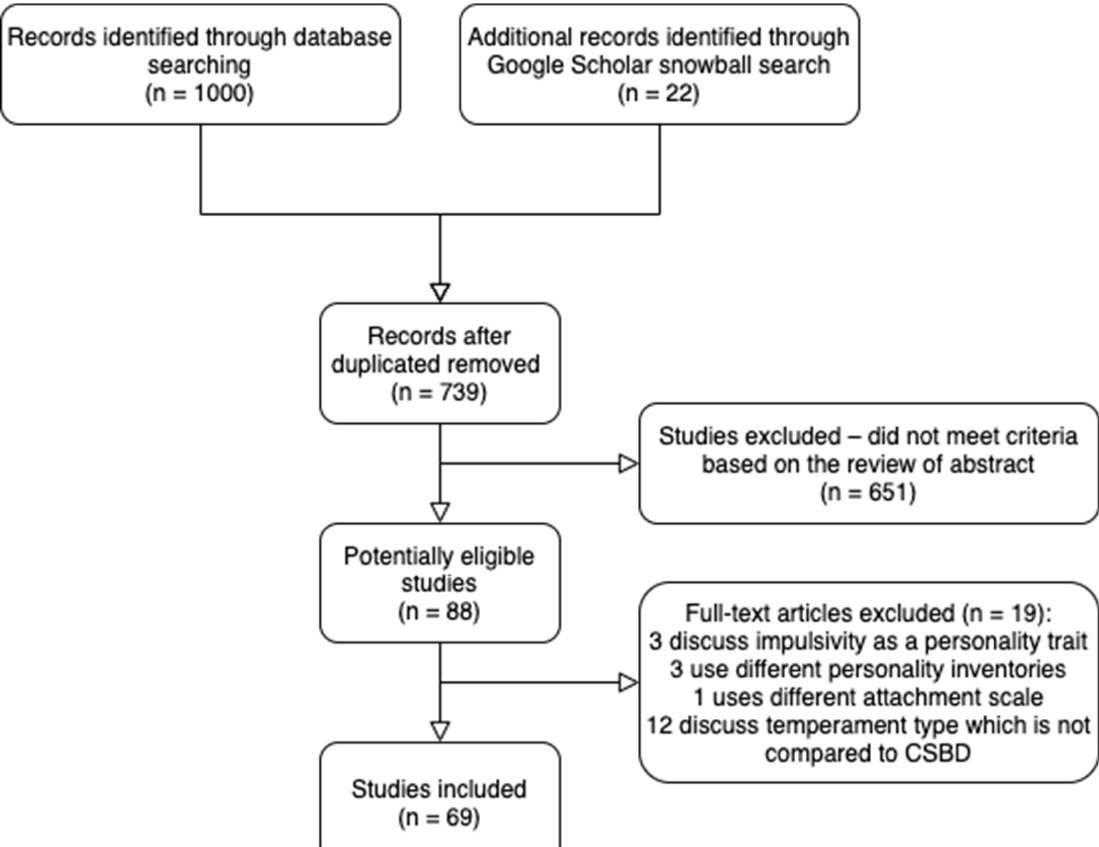
Figure 1. PRISMA flow chart regarding paper selection process ( n = 1022).